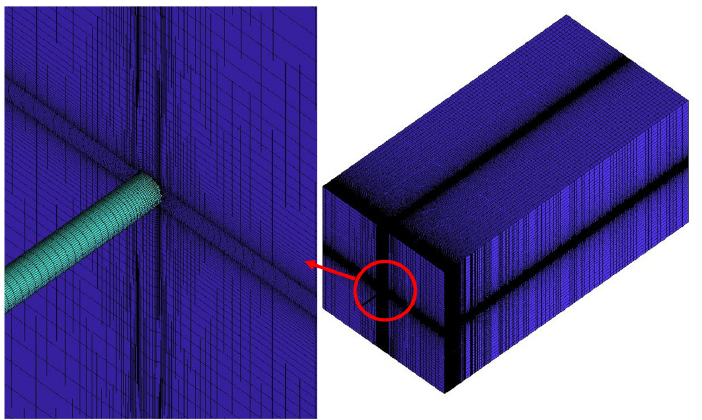
Figure 1. Mesh independence on the number of nodes.